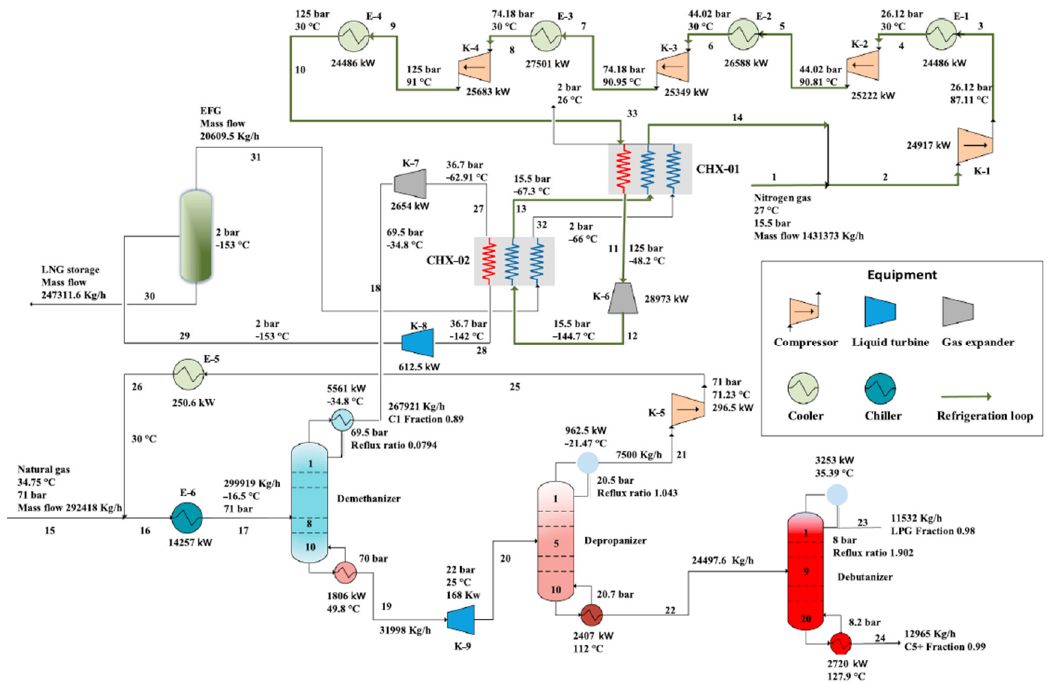
Figure 20. Process flow diagram of the proposed optimized process for LNG-LPG-pentane plus production [63]. Reproduced with permission from Elsevier (license number